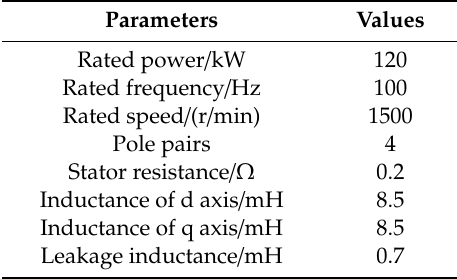
Table 1. Three phase permanent-magnet synchronous motor parameters.